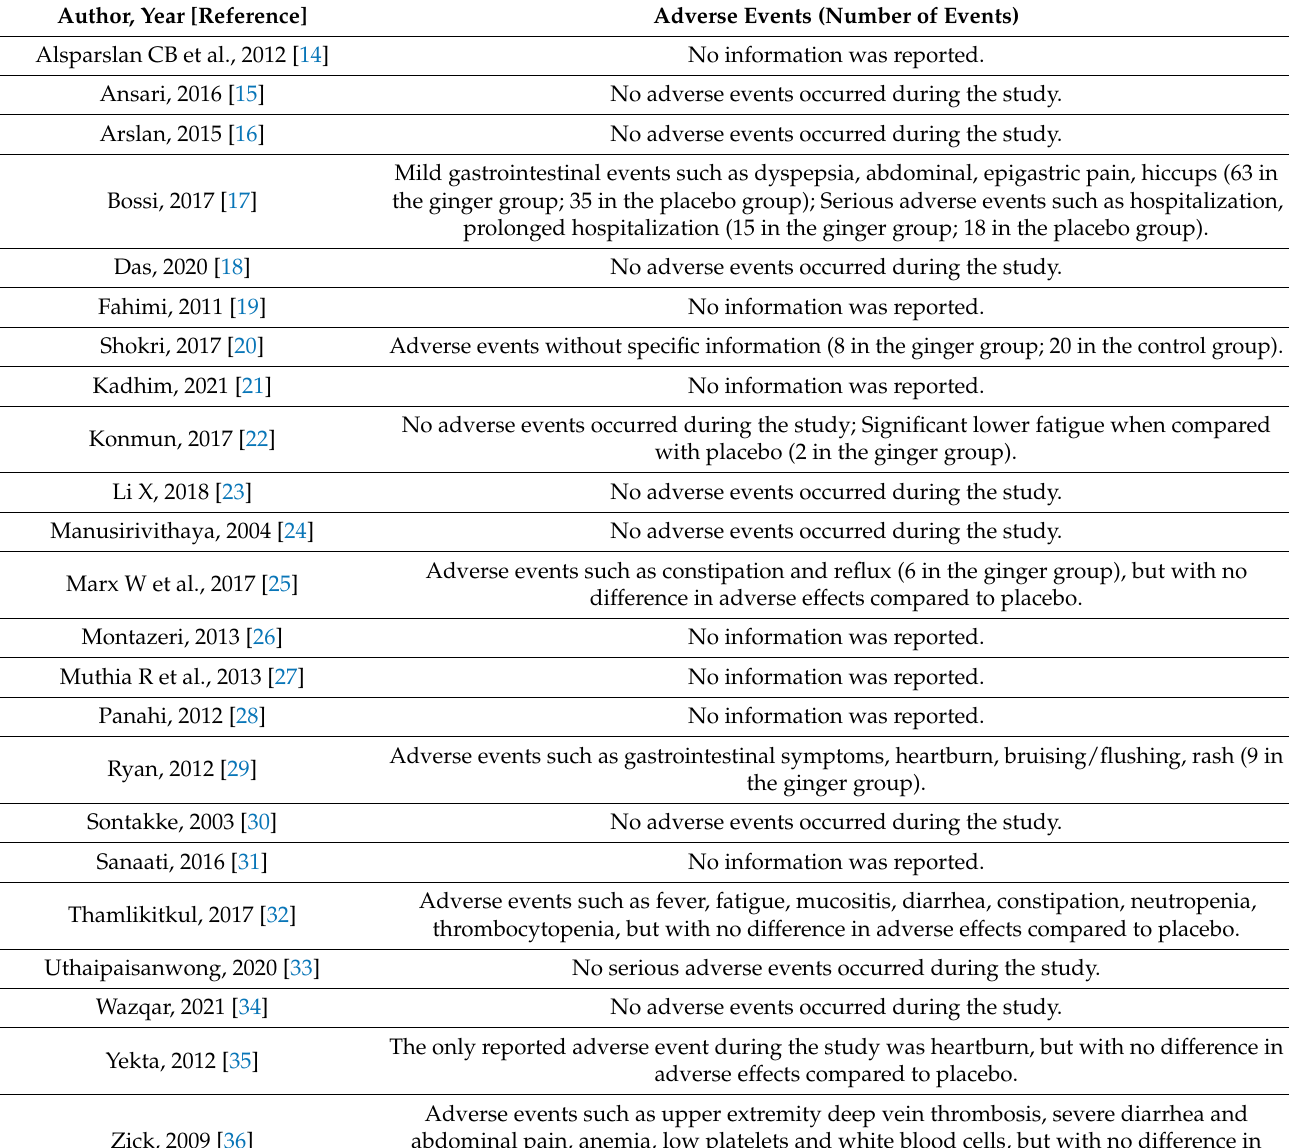
Table 3. Reported adverse events after intake of